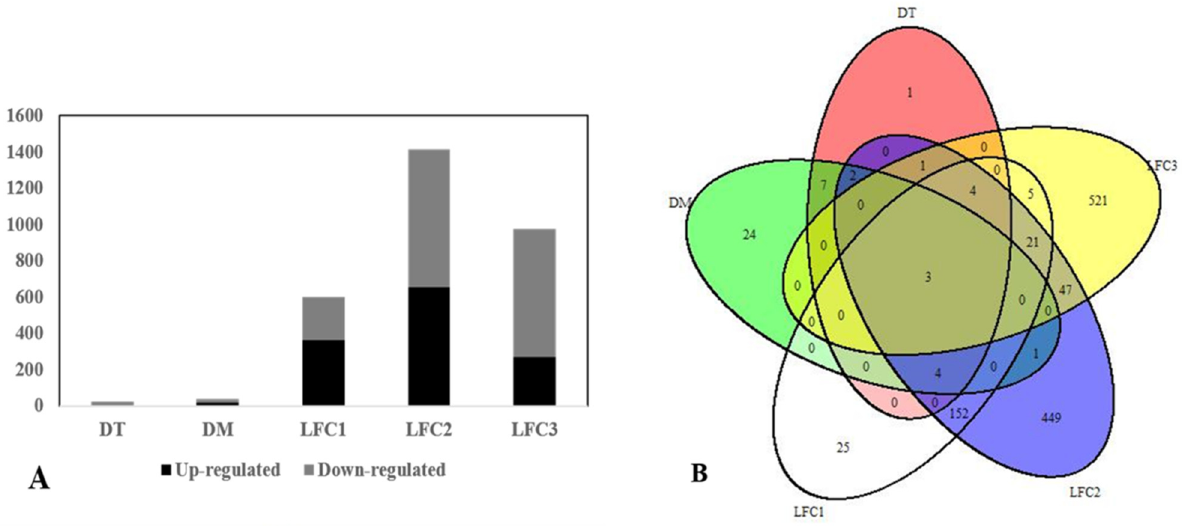
Figure 3. Number of differentially expressed genes (DEGs) in pea resistant (R) or susceptible (S) to Aphanomyces root rot, as detected by two in silico mixes and log2 fold change comparisons, as well as the overlap among these DEGs. ( A ) Overview of the number of significantly up-regulated and down-regulated genes. ( B ) The overlap in DEGs in a Venn diagram. ‘DT’ indicates DEGs determined by DESeq analysis from an in silico mix with three replicates; ‘DM’ indicates DEGs determined by DESeq analysis from an in silico mix with two replicates and ‘LFC1-3’ indicates log2 fold change comparison of individual R-S pairs (R1-S1, R2-S2 and R3-S3).